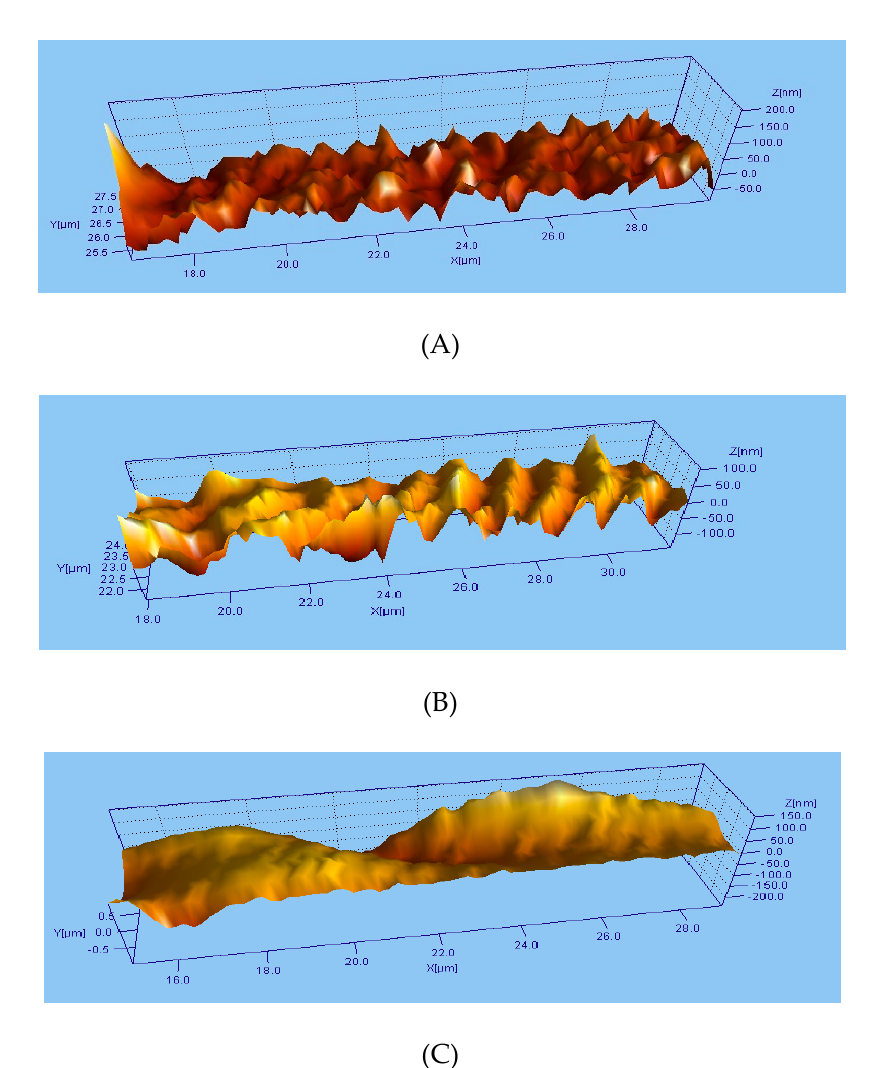
Figure 5. 3D surface structure of the ( A ) unmodified, ( B ) AEBSF-modified, and ( C ) α 1 -AT-modified Uni-Graft prosthesis.